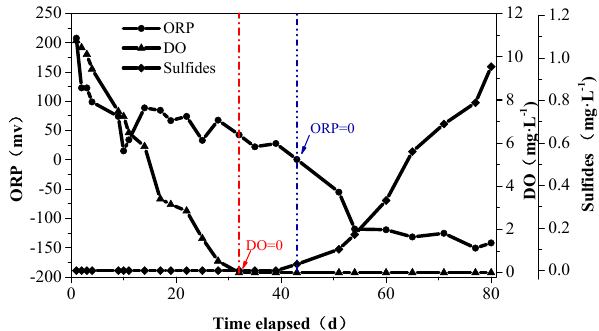
Figure 7. The variation of sulfides, DO, and ORP with the reaction time in the experimental